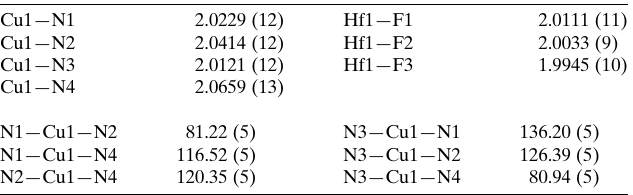
Table 3 Selected geometric parameters (A˚ , (cid:4) ) for (II).